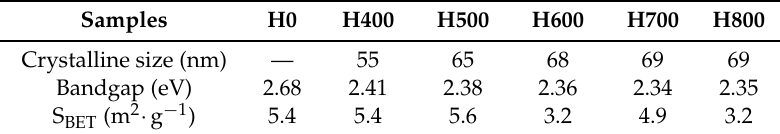
Table 1. Some selected properties of BiVO 4 samples.